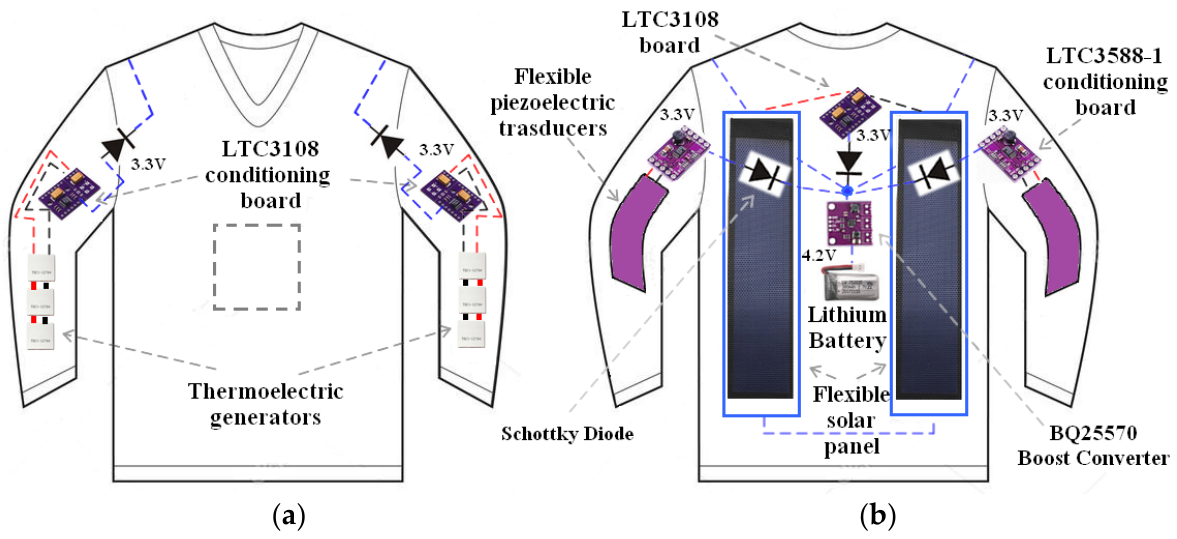
Figure 3. Graphical illustration of the multisource energy harvesting section, which shows the connections between the harvesters and conditioning modules integrated into the garment. Front view ( a ) and rear ( b ) views of the designed garment with highlighted the harvesting section.